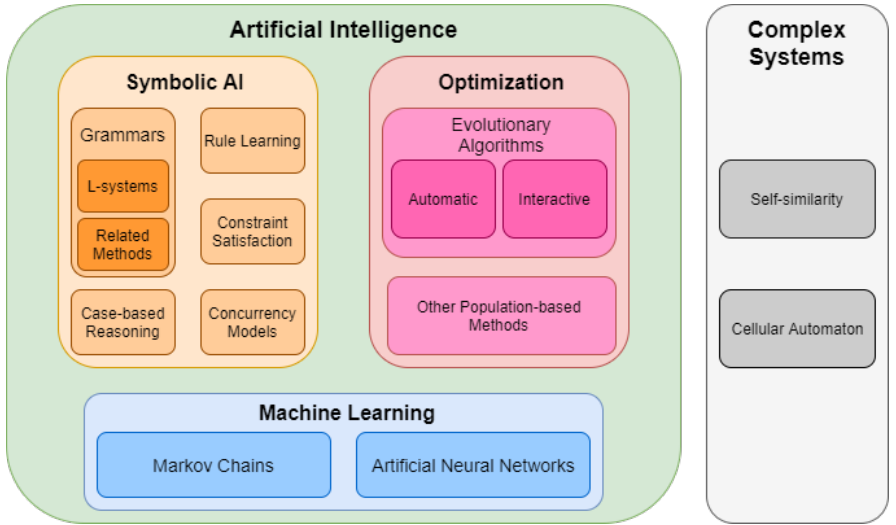
Figure 3. Categories of algorithms for automatic